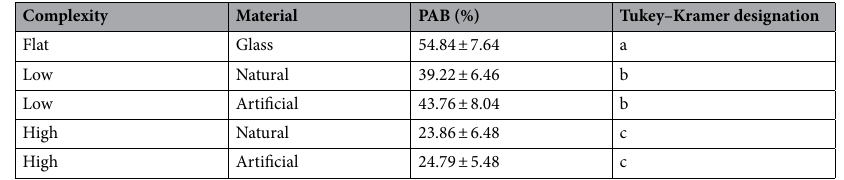
Table 3. Predator avoidance behaviour (PAB) values (mean ± 1SE) under five different experimental treatments of habitat complexity and material used to create structure. Tukey–Kramer designations show results of post hoc analysis of the two-way ANOVA to show where differences between treatments occur.